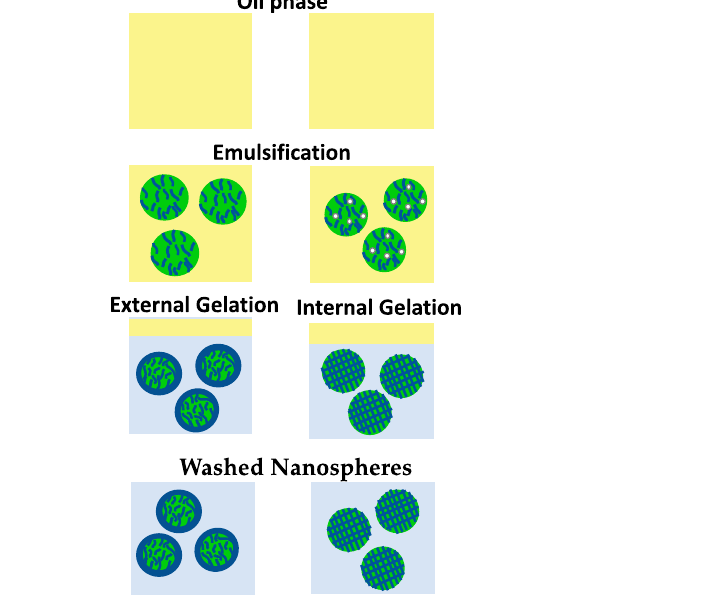
Figure 3. Schematic presentation of alginate nanospheres preparation by means of emulsification (external/internal) gelation method.